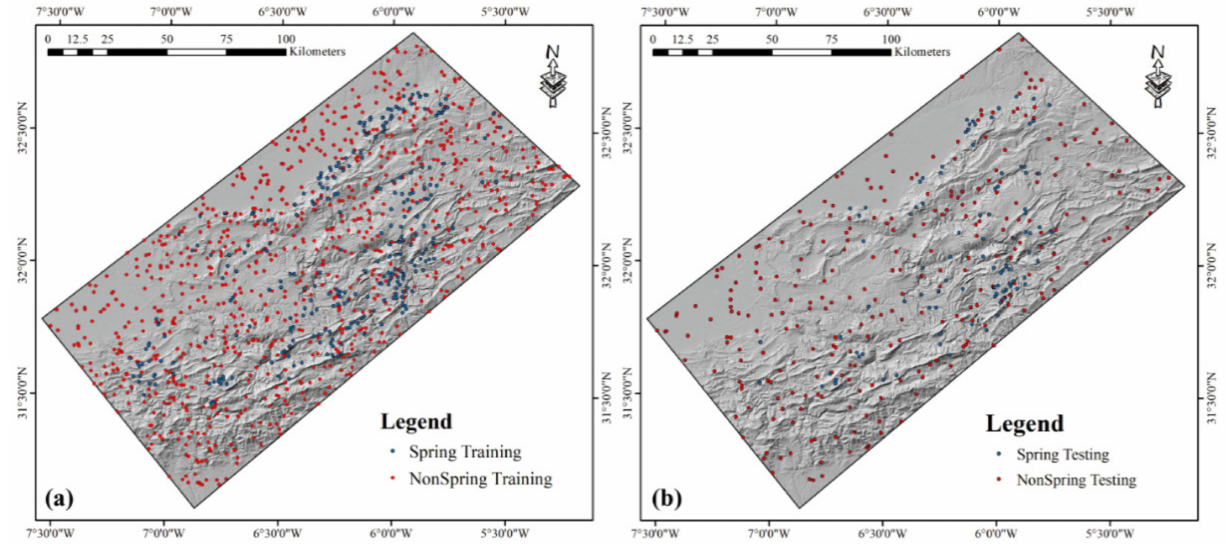
Figure 4. Location of springs and non-springs in the study area, ( a ) Training datasets and ( b ) Testing